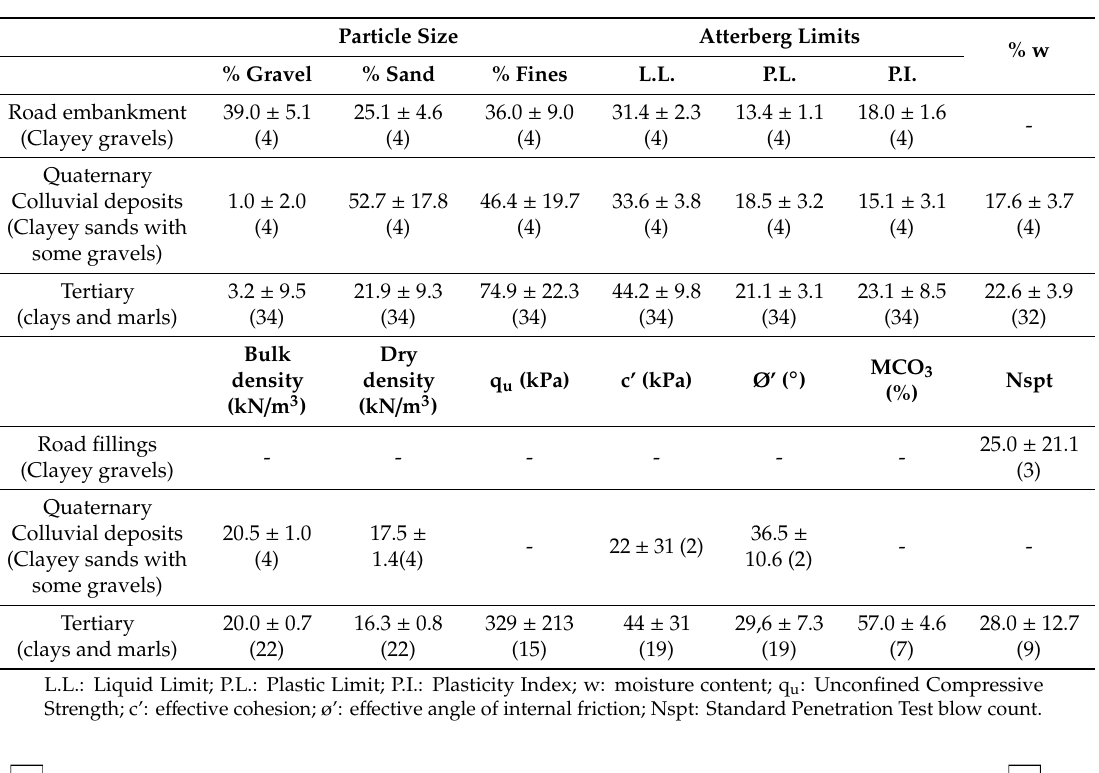
Table 1. Geotechnical properties of soils. Mean value, standard deviation, and in parentheses the number of tests done.